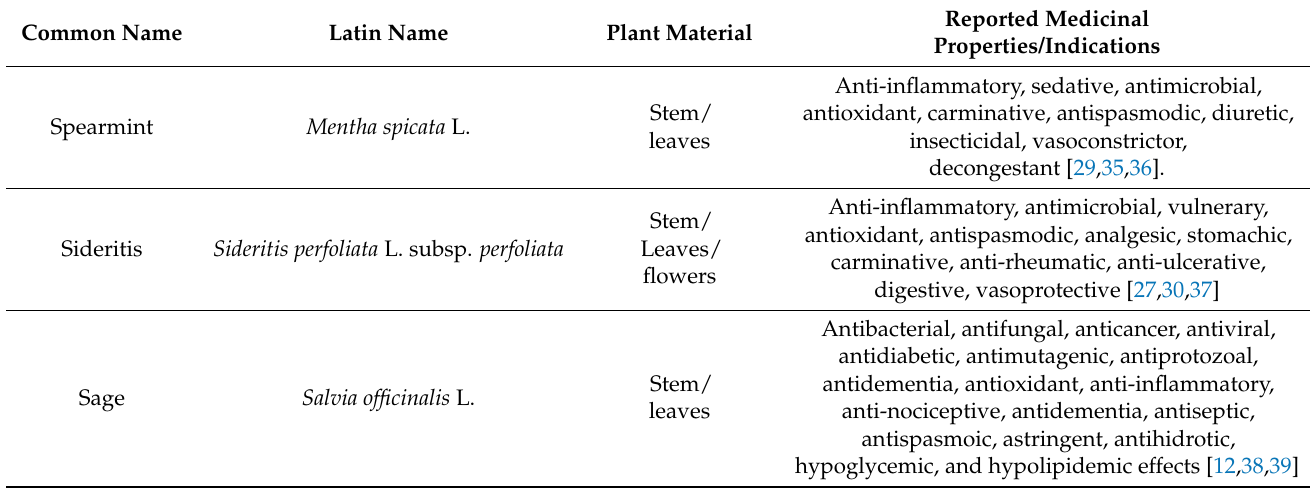
Table 1. Lamiaceae family plant species and material